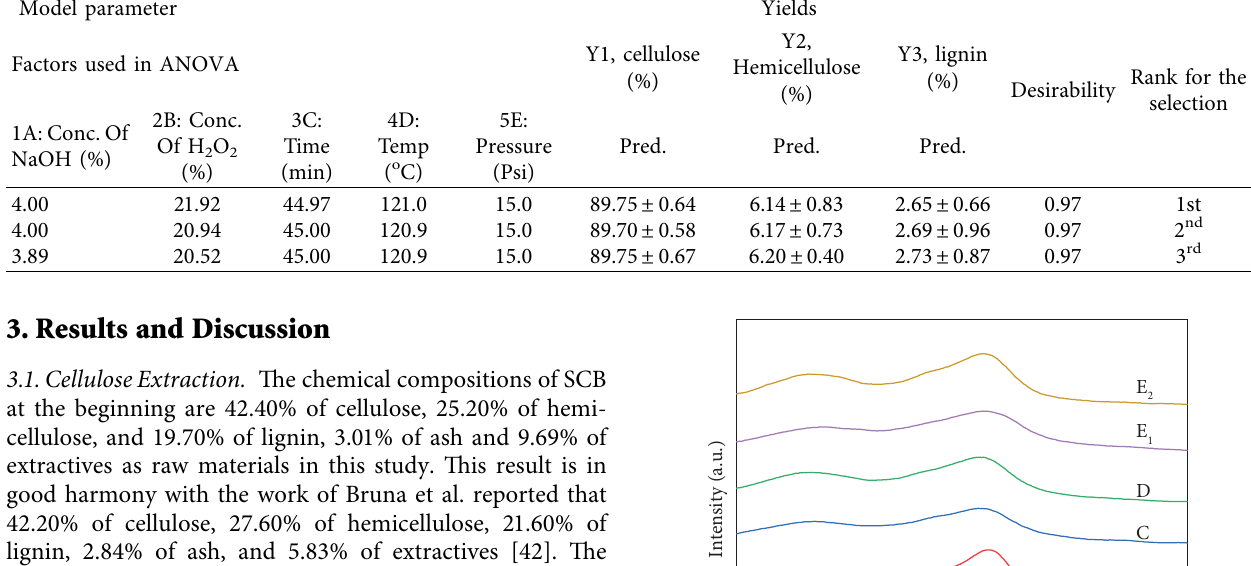
Rank for the Desirability